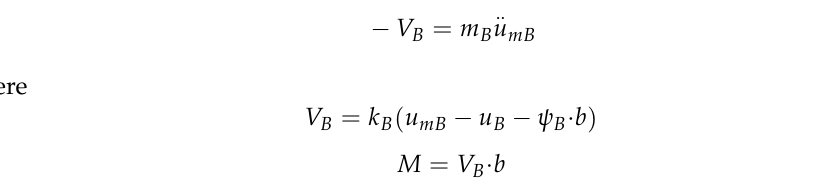
Figure 8. Free body diagram of a longitudinal force-moment type resonator.